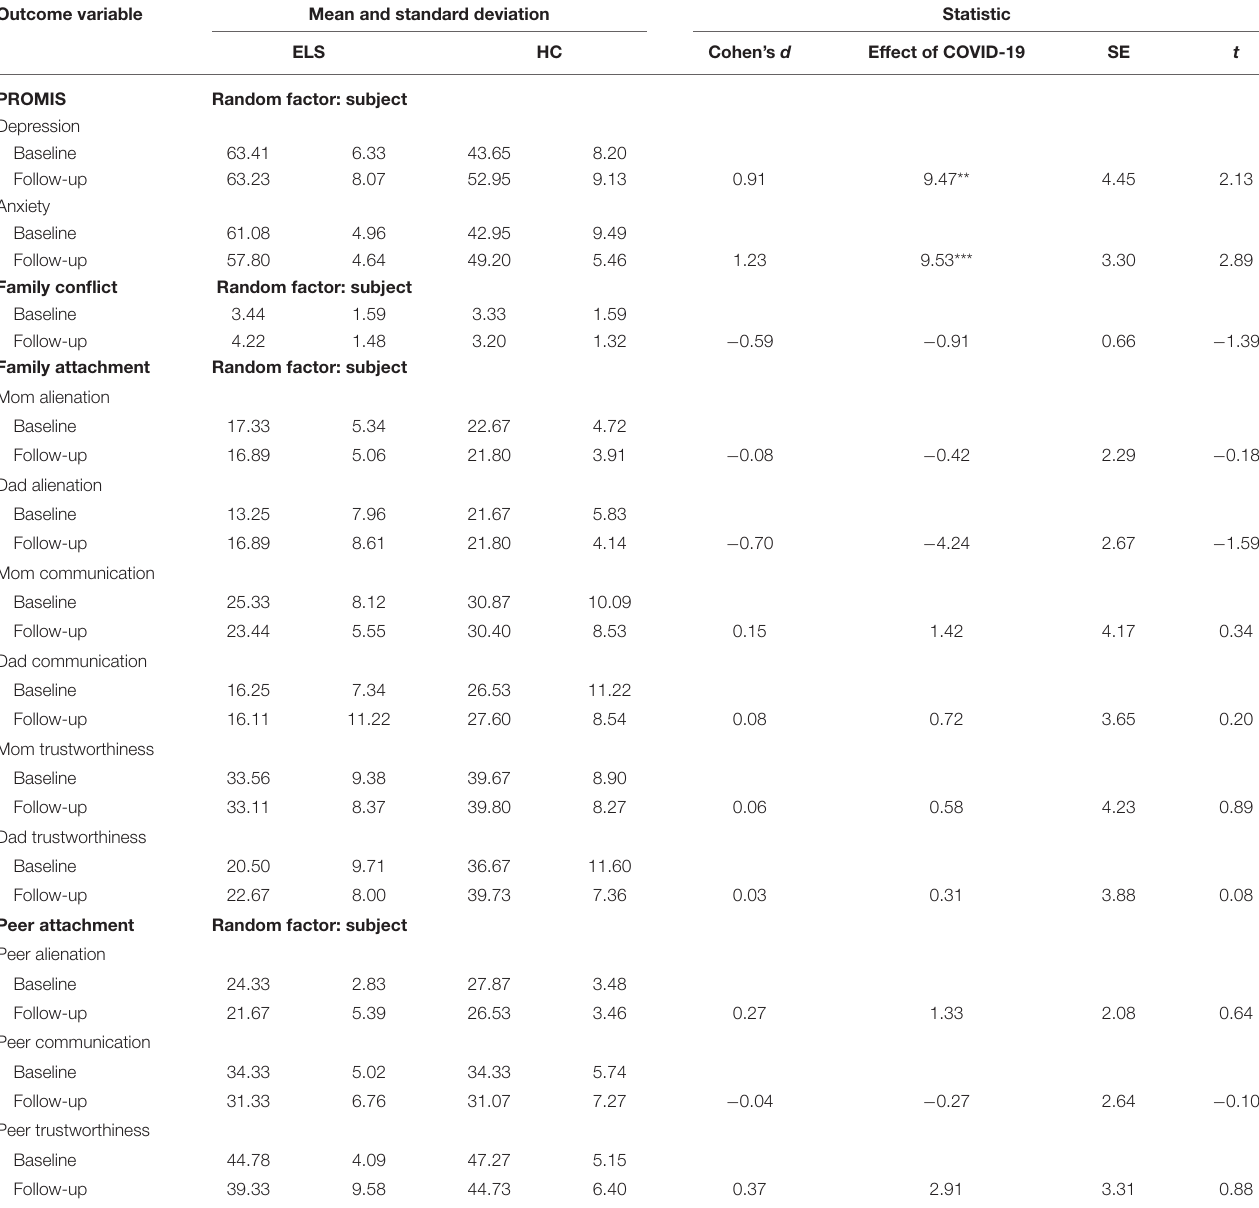
TABLE 2 | Unadjusted means, standard deviations, effect sizes, and main analyses of change from baseline in early life stress exposed compared with healthy controls. Outcome